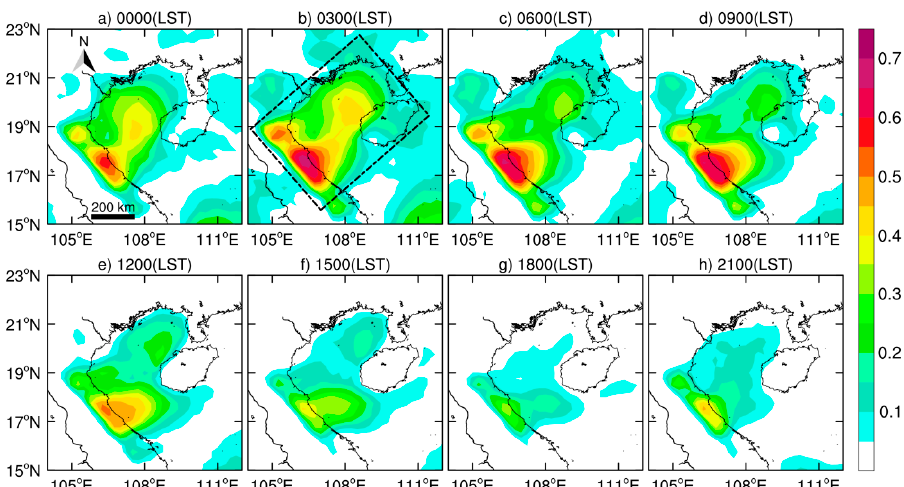
Figure 3. Hourly horizontal distribution of the occurrence rate of LLJs (shading) over the BBG in summer from 2015 to 2019 at: ( a ) 0000, ( b ) 0300, ( c ) 0600, ( d ) 0900, ( e ) 1200, ( f ) 1500, ( g ) 1800, and ( h ) 2100 h local standard time